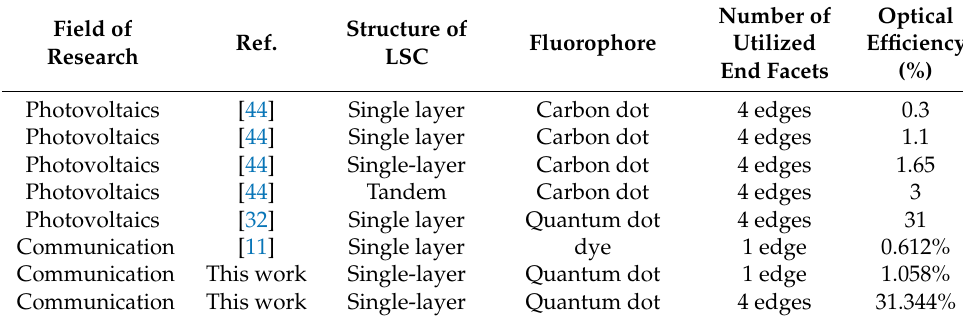
Table 1. Summary of previous